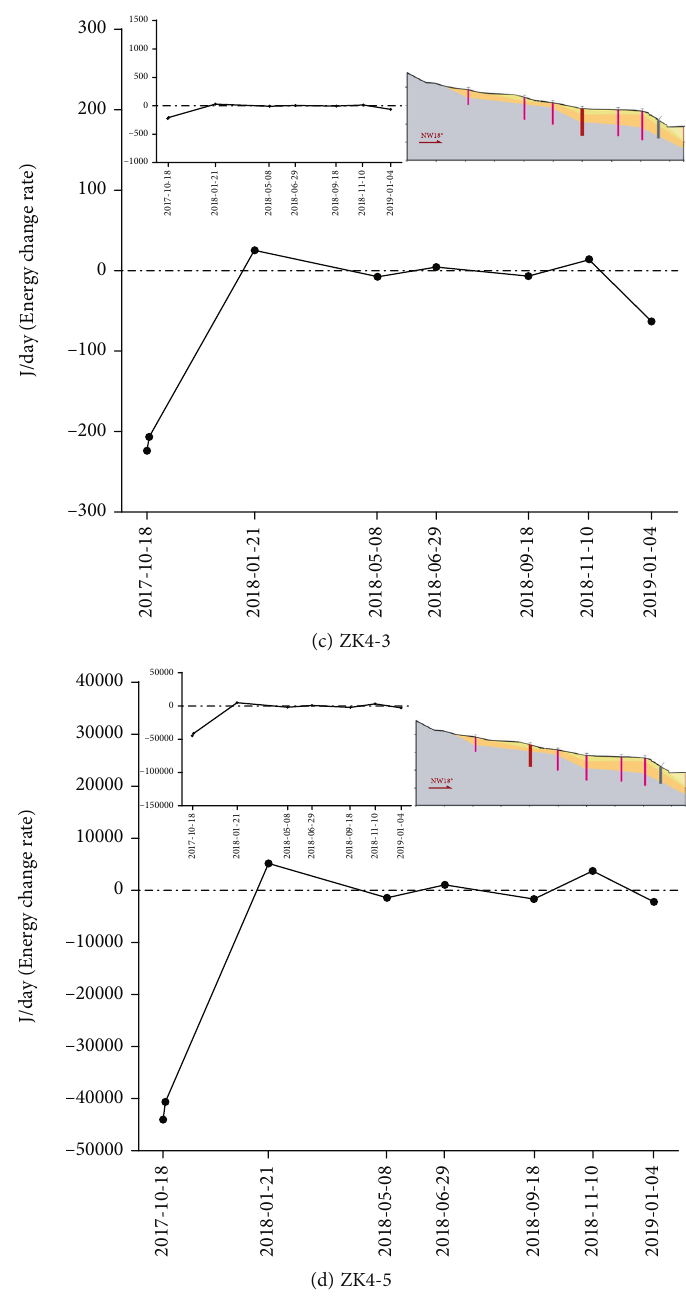
Figure 18: Change rate of kinetic energy in ZK4-1, ZK4-2, ZK4-3, and ZK4-5